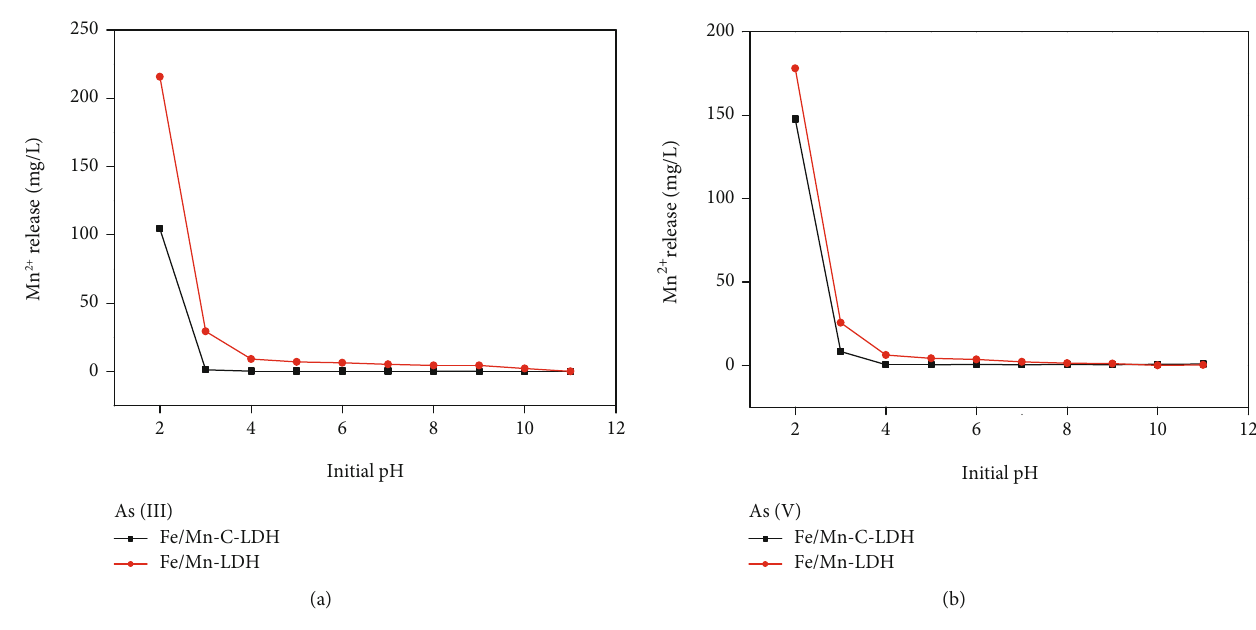
Figure 7: Mn 2+ concentration in solution at di ff erent initial